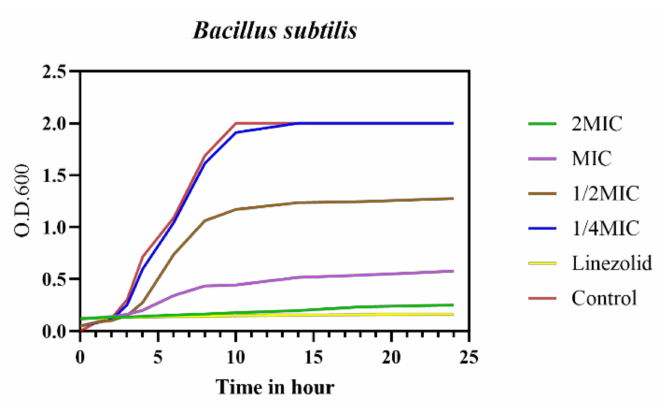
Figure 3. Inhibition of the growth of Bacillus subtilis by different concentrations of compound 12e . (MIC: minimal inhibit concentration; O. D.: optical